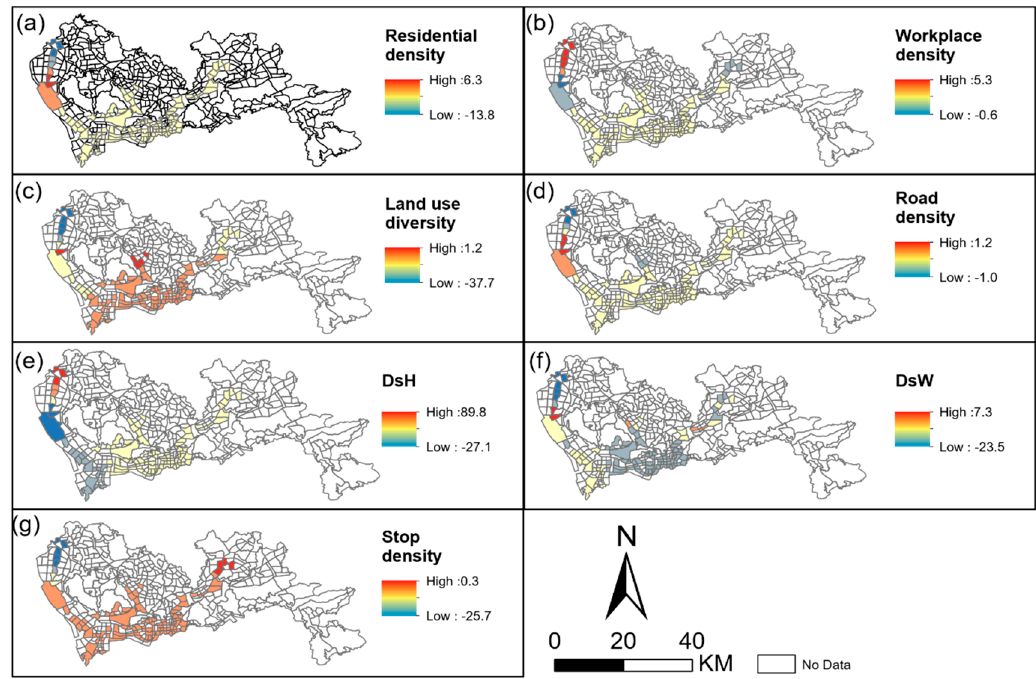
Figure 10. Local coefficients for metro ECI. ( a ) residential density; ( b ) workplace density; ( c ) land use diversity; ( d ) road density; ( e ) distance between the nearest transit stop and home (DsH); ( f ) distance between the nearest transit stop and work (DsW); ( g ) stop density.